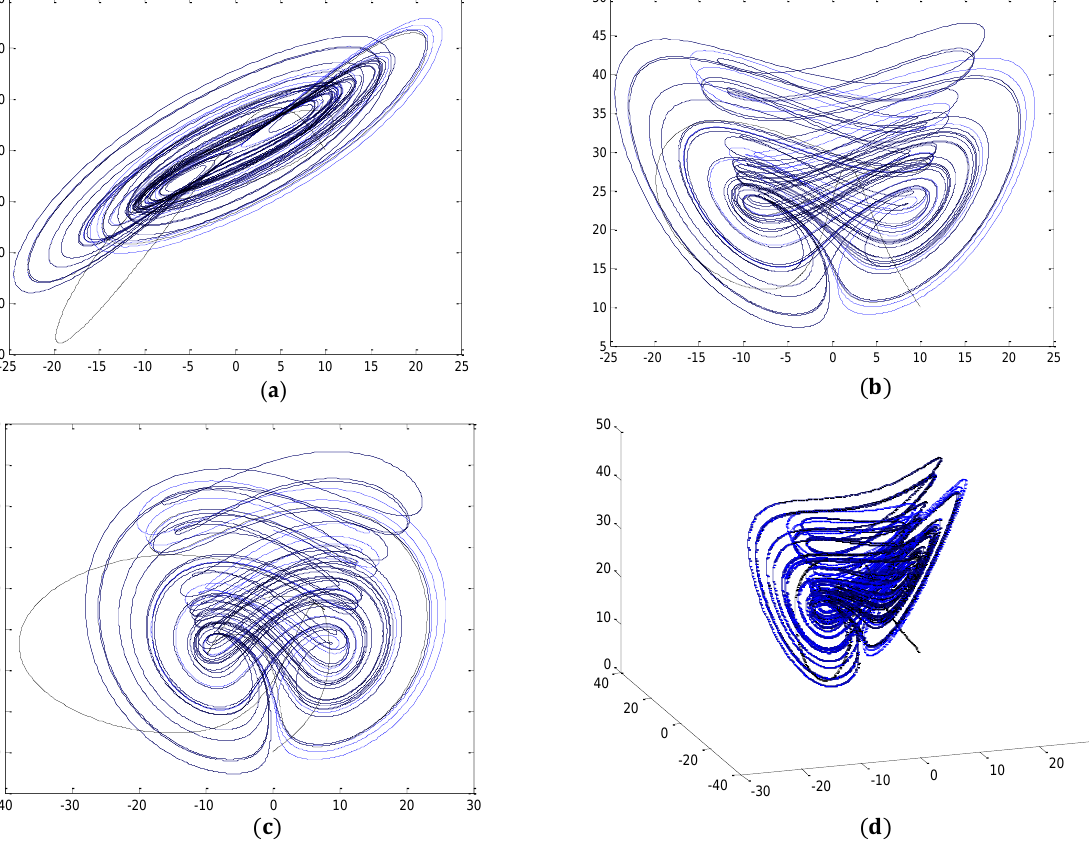
Figure 4. Fractional order derivative with 𝛼 = 0.9,𝛼 = 0.8,𝛼 = 0.5 and time delay 𝜏 = 5 s. Time-delay anti-synchronization error between the states of master and slave systems. As the first part of our research, a fractional-order PID-type control law was used, and when it was applied to system (4) (the Lorenz system), the system was forced to fol- low or synchronize with the Chen system, as can be seen in the Figure 5 with 𝛼 = 0.9, the phase portraits for the time delay synchronization between Chen and Lorenz Chaotic systems and in Figure 6 fractional variable order derivative with 𝛼 = 0.9, 𝛼 = 0.8, and 𝛼 = 0.5.